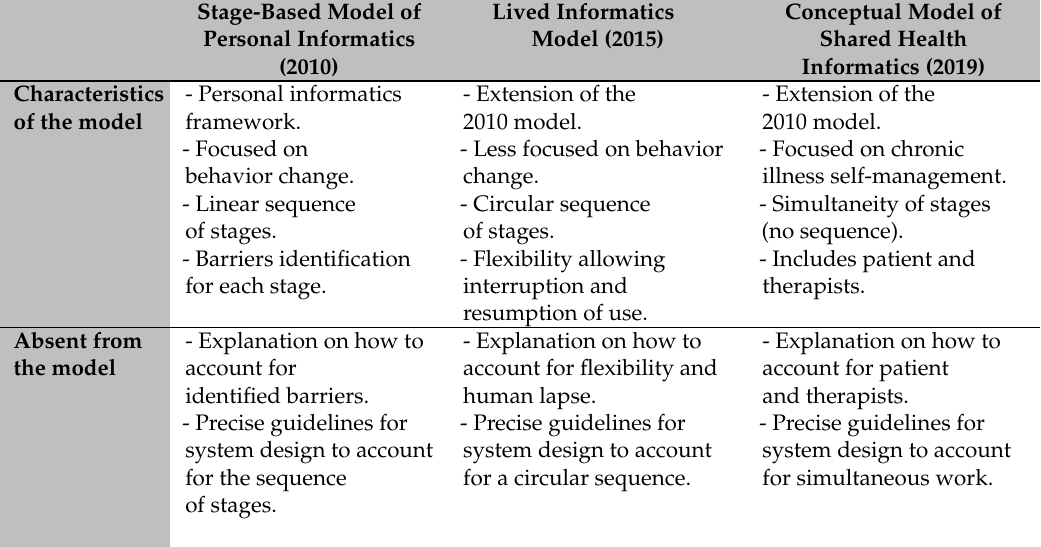
Table 3. Principal Models of Quantified Self. This table summarizes the present and absent characteristics of the main descriptive models of quantified